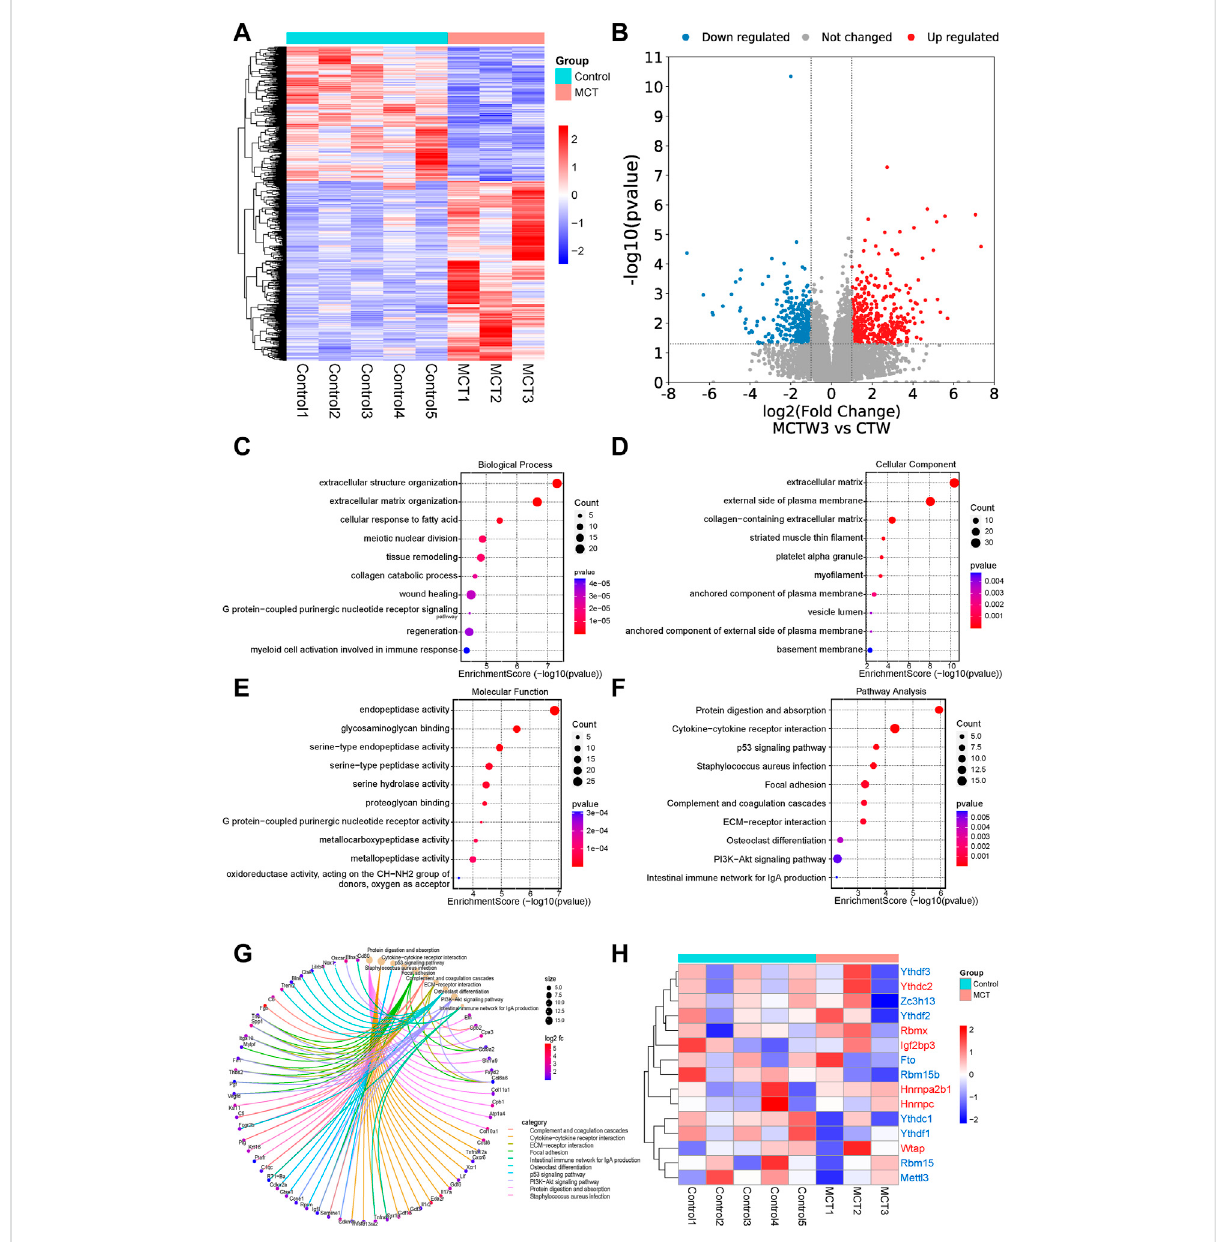
FIGURE 1 The RNA sequencing analysis revealed that the monocrotaline-induced PAH samples exhibited dysregulated expression of m6A regulators. (A) Theheatmapand (B) volcano maprevealedtheDEGsintheMCT – PAHratlungsamplescomparedtothecontrols.TheresultsoftheGOanalysis, (C) Biological process (D) cellular component (E) molecular function analysis revealed the potential signaling pathways regulated by the upregulated DEGsintheMCTgroupscomparedtothecontrols. (F) PathwayanalysisoftheupregulatedDEGs via KEGGanalysis. (G) Thegenesthatregulated the above functions are depicted. (H) The heatmap for the expressions of 15 m6A regulators in the two